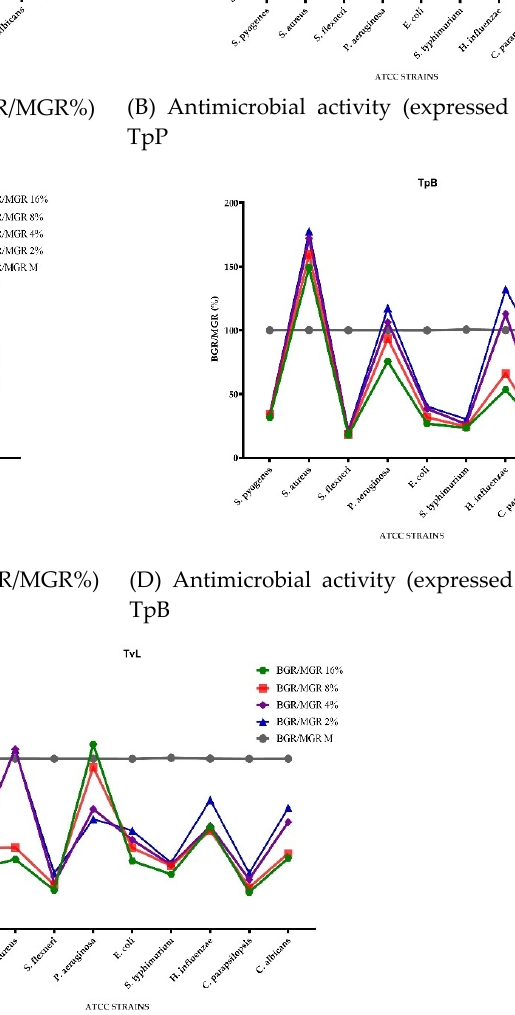
Figure 2. Antimicrobial activity of analyzed EOs expressed as BGR/MGR (%): ( A ) TgS; ( B ) TpB; ( C ) TpC; ( D ) TpP; ( E ) TvL.